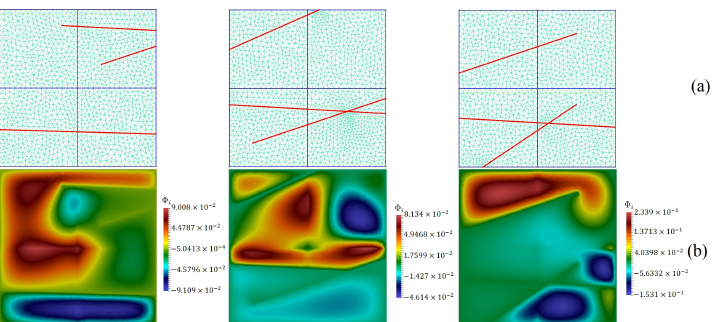
Figure 3. Illustration of the online multiscale basis functions for three local domains. ( a ): local domains ω i . ( b ): solution of (13) and